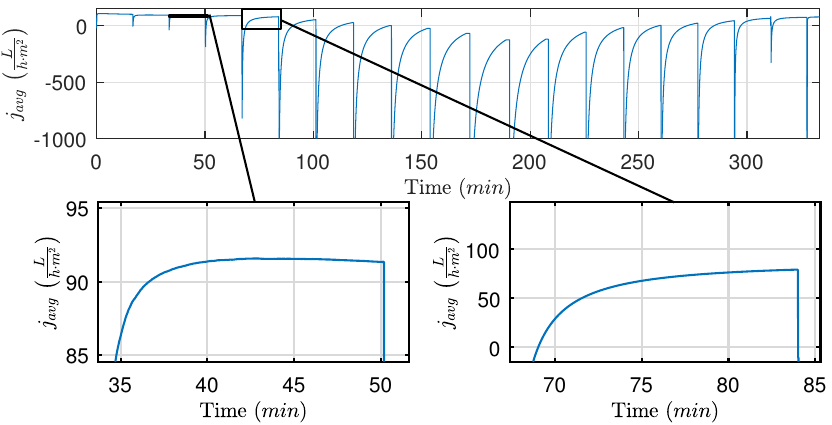
Figure 10. Estimated average flux ( j avg ), based on the data from Figure 5. The bottom left and right figure are the average flux with a backwashing duration of 3.1 s and 9.1 s, respectively.